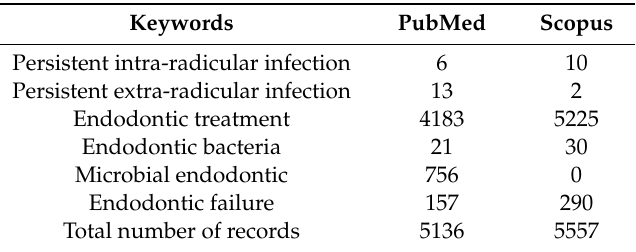
Table 2. A complete overview of the search methodology, illustrating the keywords used, the Boolean operators adopted, and the number of records obtained for each online